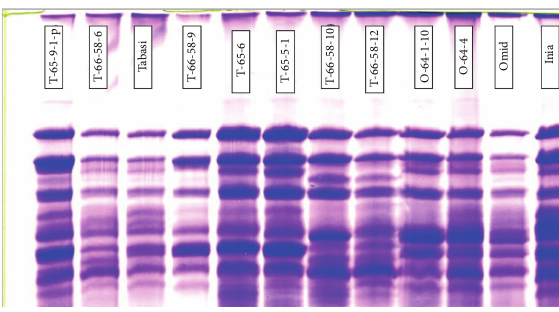
Figure 2: SDS-PAGE polyacrylamide gel for seed storage protein.